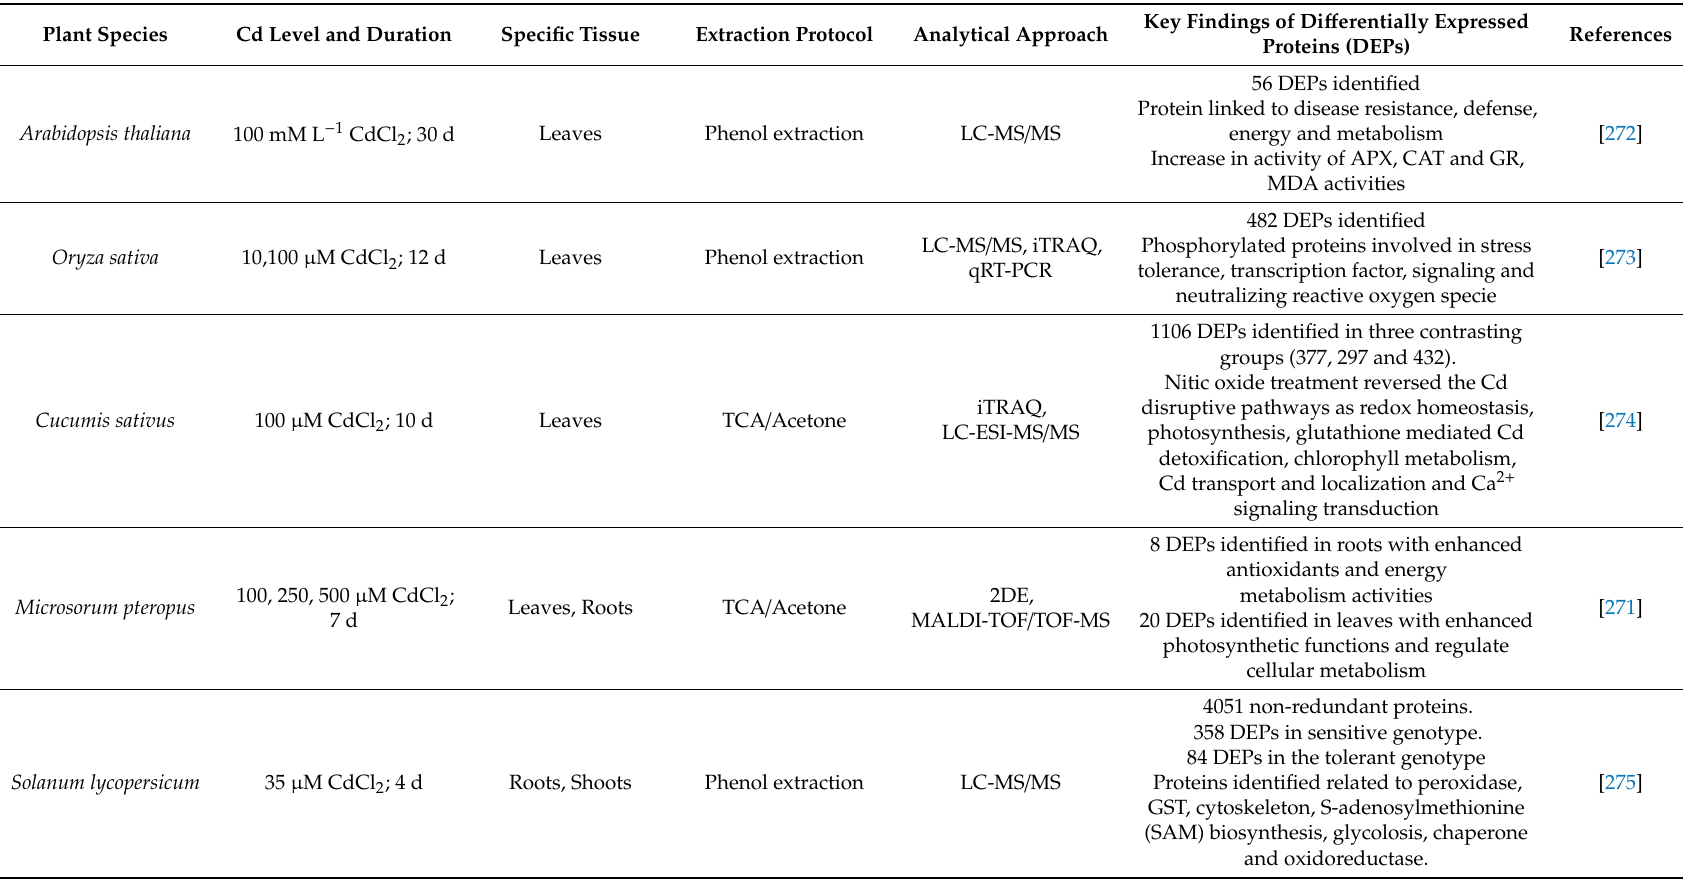
Table 5. Summary of experiments directed using proteomics platforms under Cd stress in